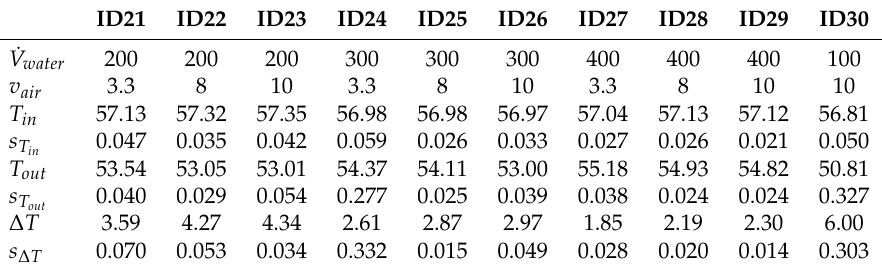
Table 6. Results of measurement in position